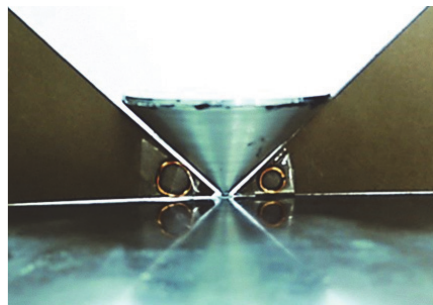
Figure 14: Fabricated dual band suppressed conical monopole UWB